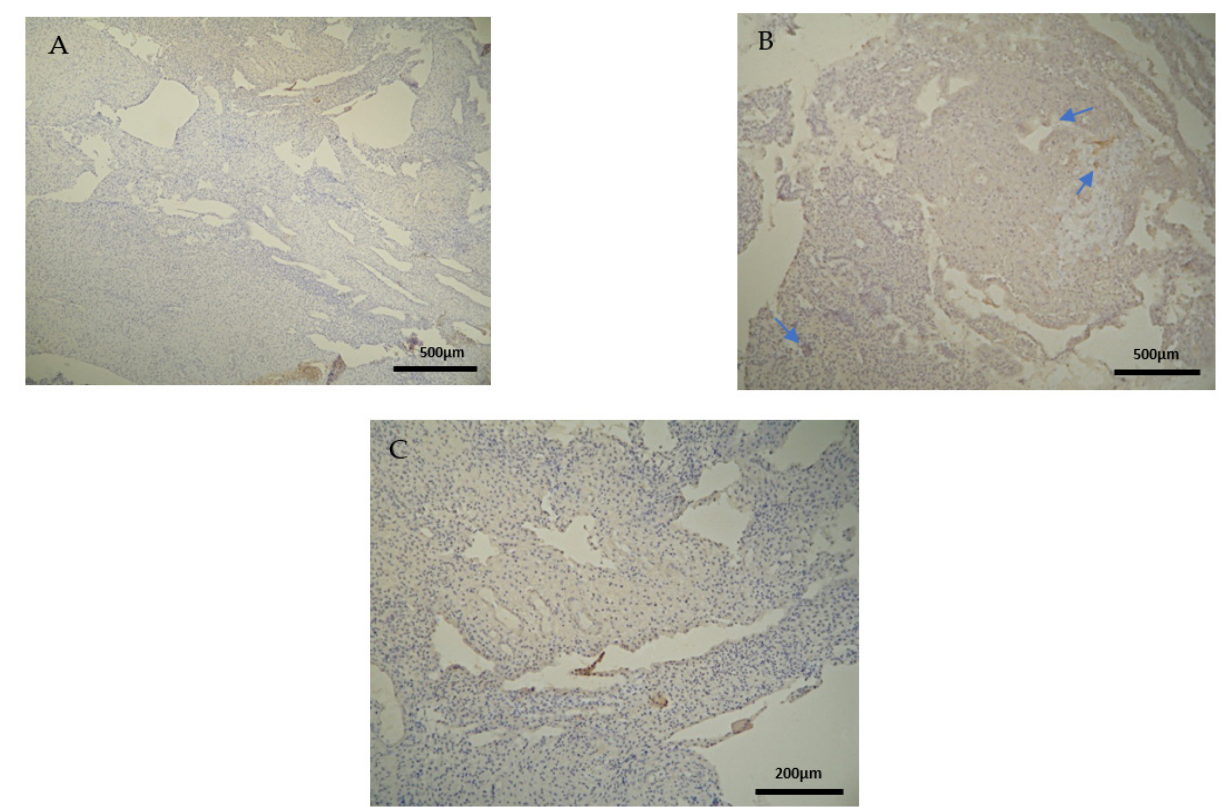
Figure 2. Evaluation of positive CD3 antigen expression. Control Group (CG): ( A ) there was no expression of CD3 in the DP (4 × 4 magnification). ( B ) There was moderate CD3 positive expression in the DB (4 × 4 magnification). ( C ) Decidua basalis and chorionic villi (4 × 10 magnification).